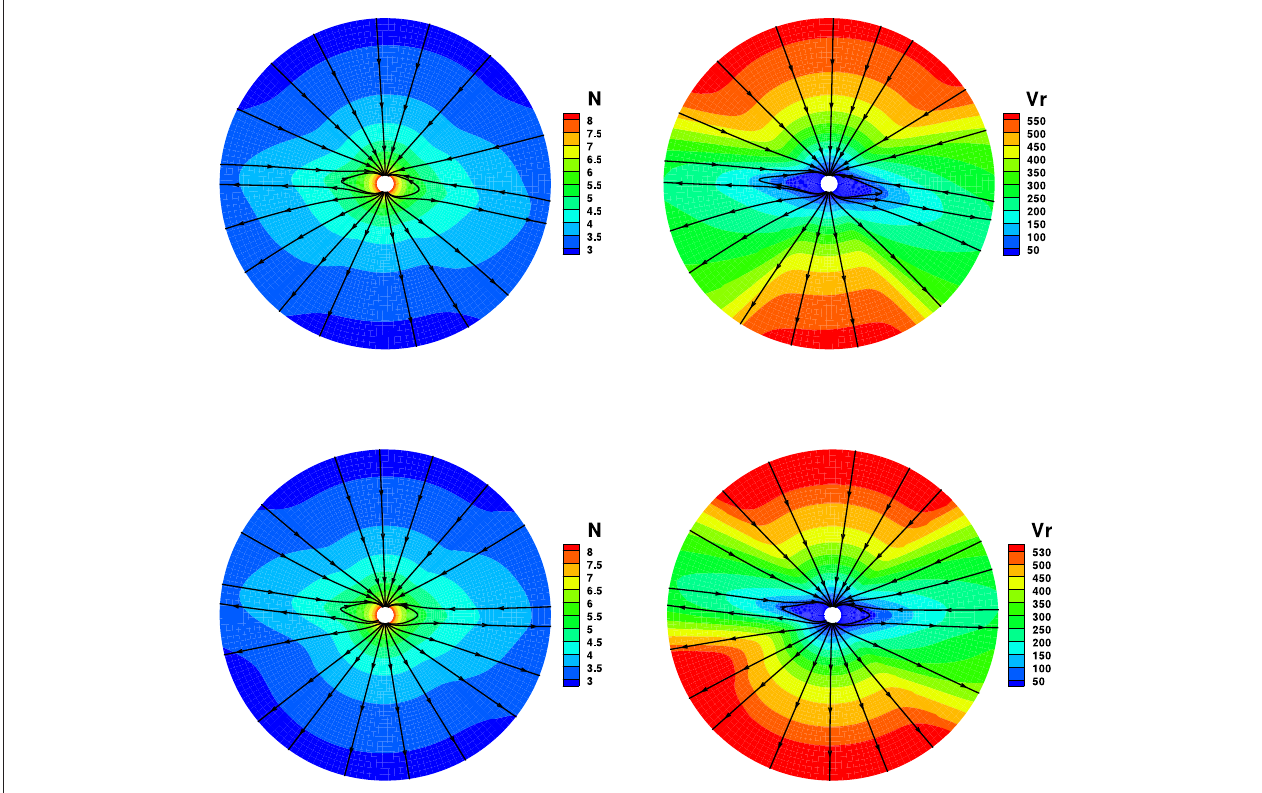
FIGURE 5 | The model results with GLM divergence cleaning method, the magnetic field lines, radial speed v r (km/s), and number density N ( log 10 / cm 3 ) on the meridional plane of φ = 180 ◦ − 0 ◦ (top) and φ = 270 ◦ − 90 ◦ (bottom) from 1 to 20 R s .